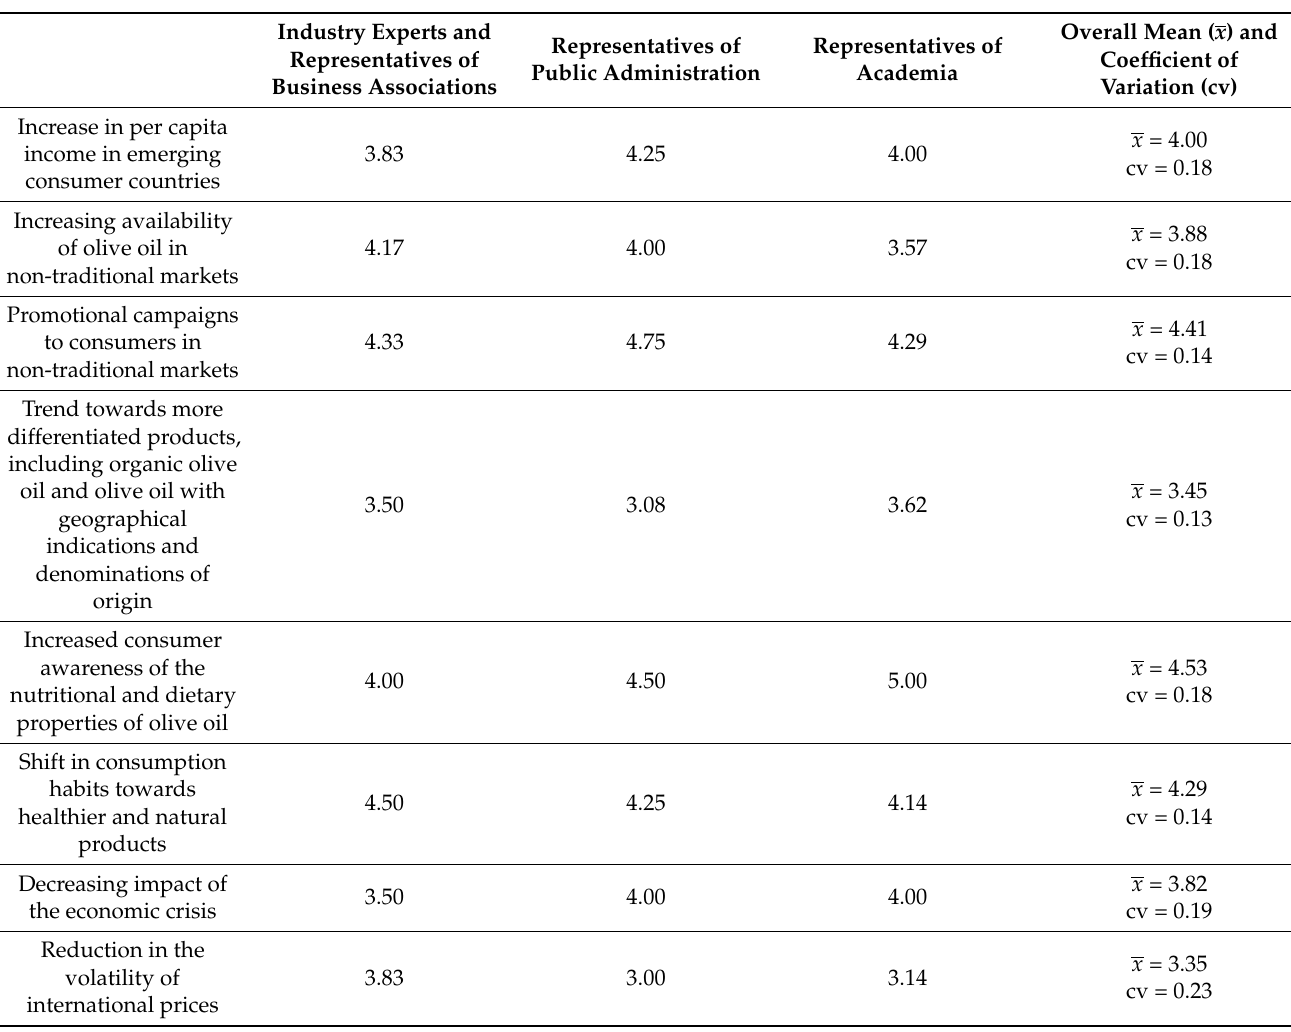
Table 4. Conditioning factors of the future increase in the global demand for olive